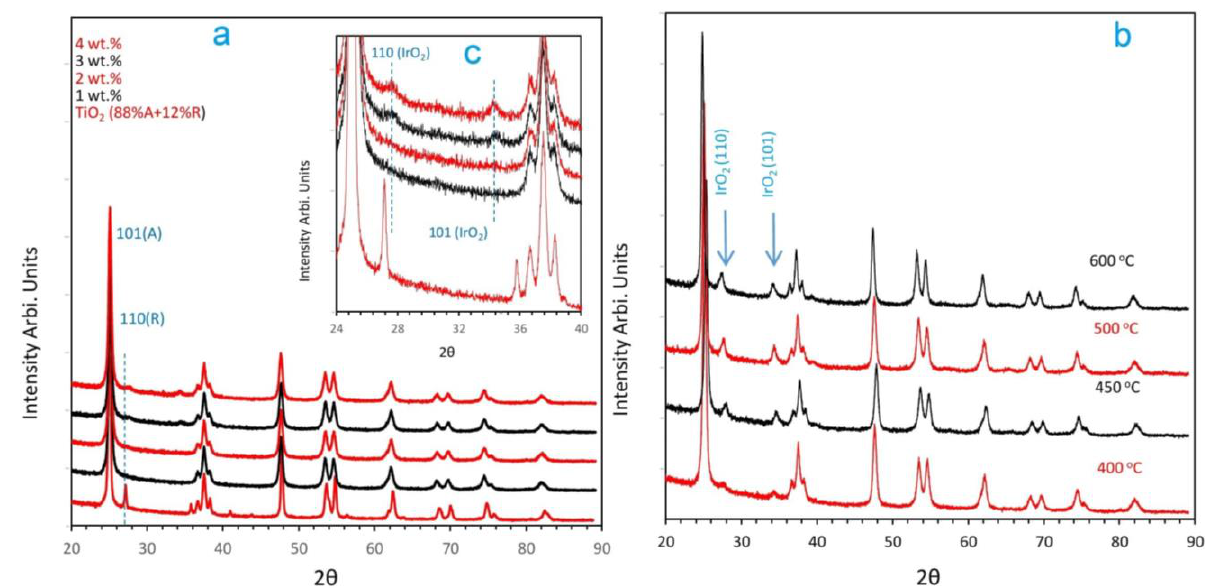
Figure 4. XRD patterns of IrO 2 /TiO 2 catalysts ( a ) with the indicated Ir wt.% loading and ( b ) with 4 wt.% Ir on TiO 2 as a function of calcination temperature. ( c ) The inset in ( a ) is an expanded section to highlight the (110) and (101) peaks attributed to IrO 2 as a function of their concentration. The TiO 2 (88% A + 12% R) is shown as a reference and was not used as a support in this study.